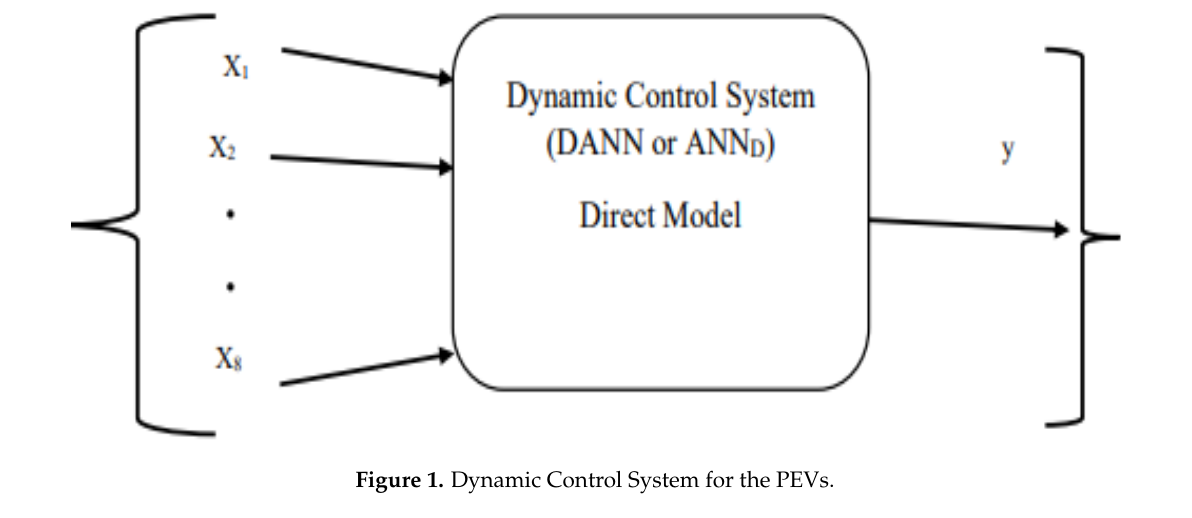
Figure 1. Dynamic Control System for the PEVs.